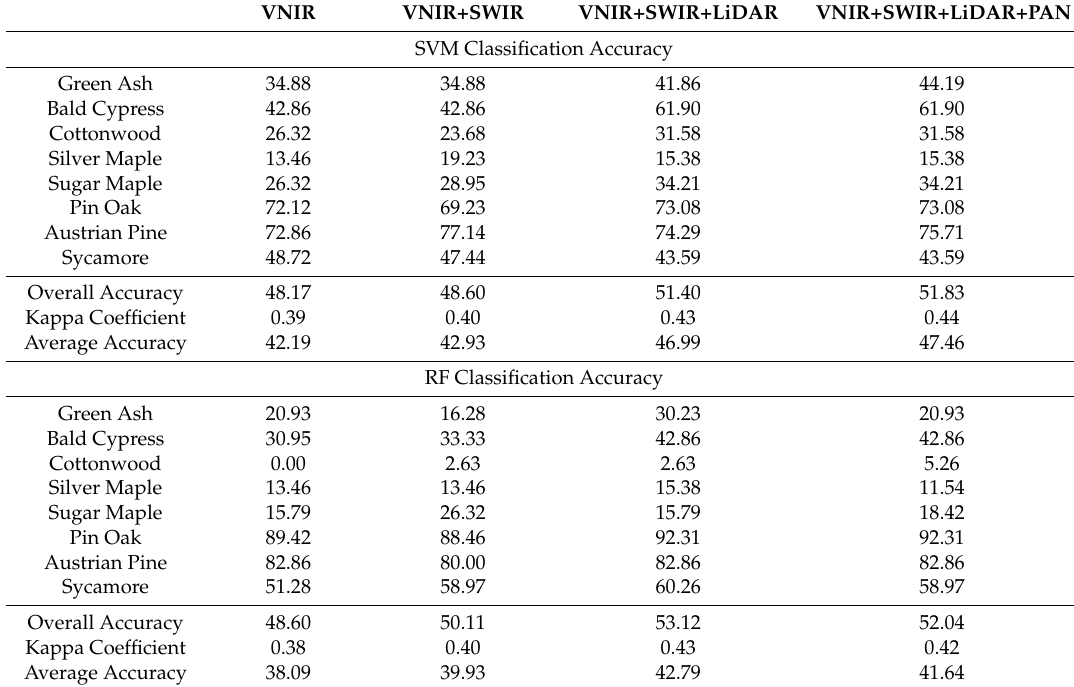
Table 6. Classification accuracies for 8 dominant tree species using fused datasets with SVM and RF classifiers using 30% training and 70% testing of each species total reference samples. All values, except for the kappa coefficient, are